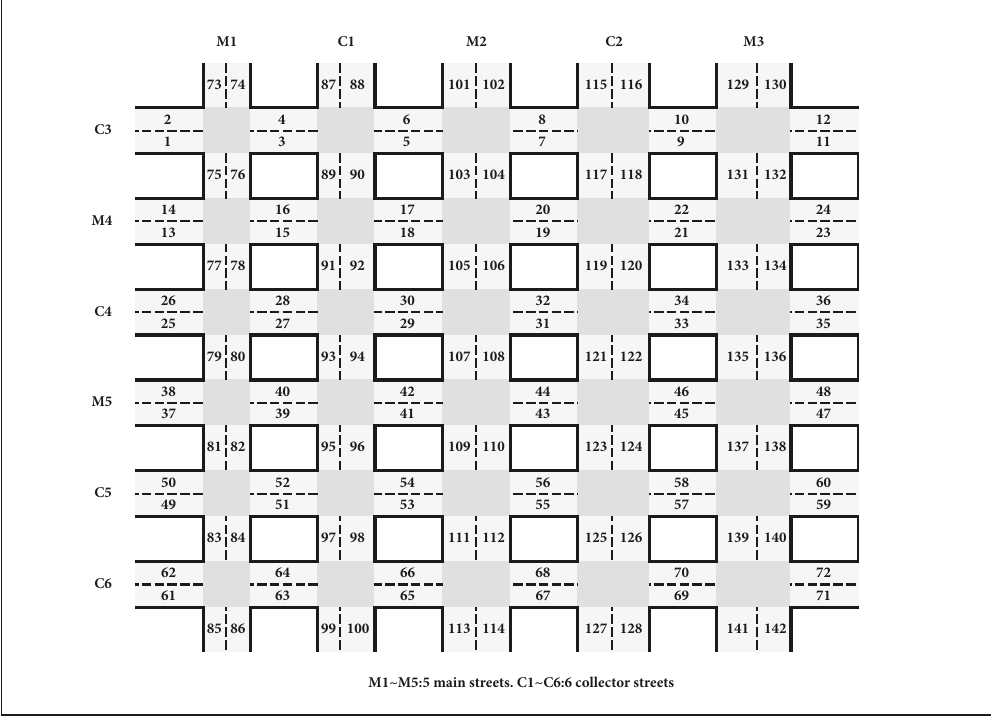
Figure 1: Structure of virtual